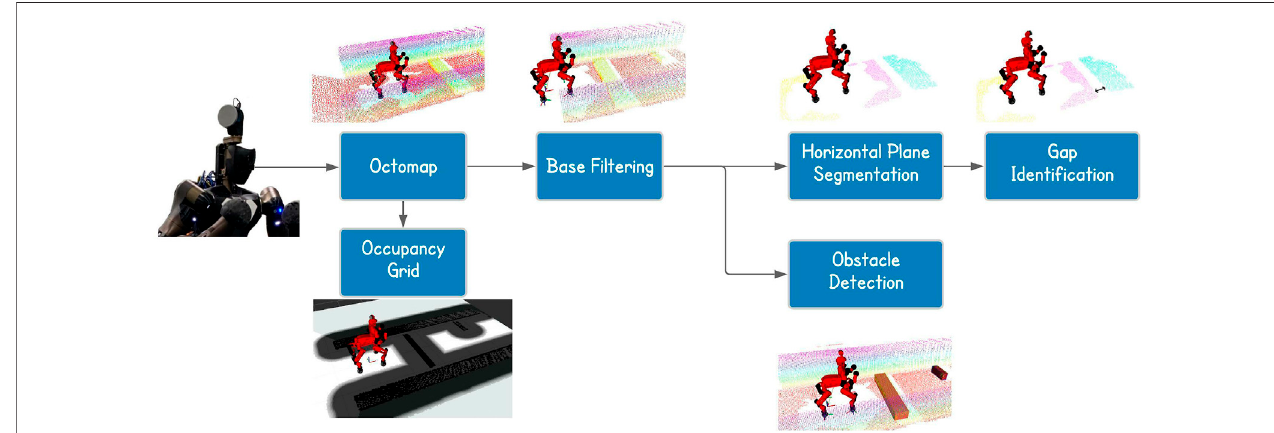
FIGURE 2 | Overview of the pipeline of the perception component.